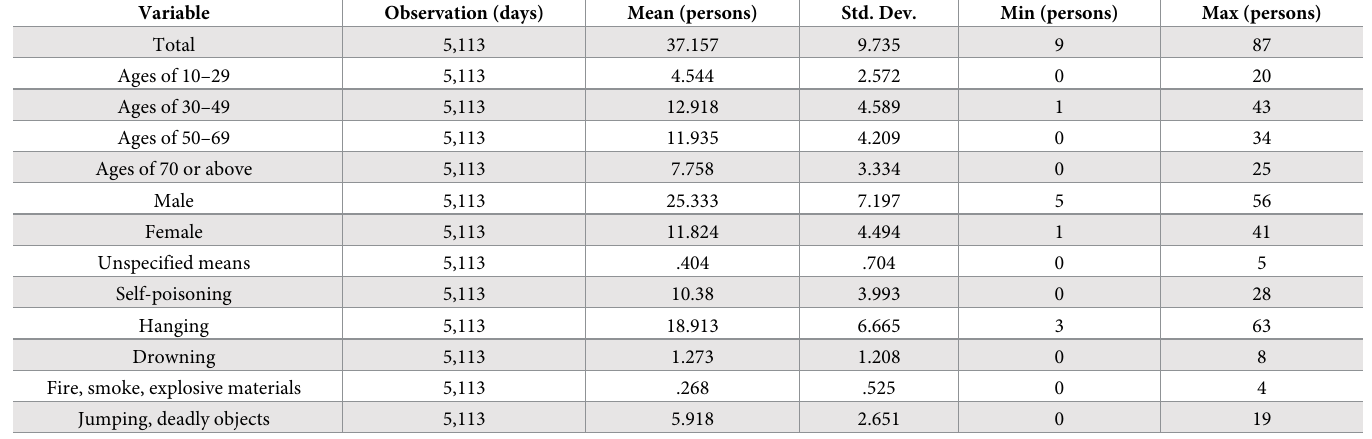
Table 1. Summary statistics for daily